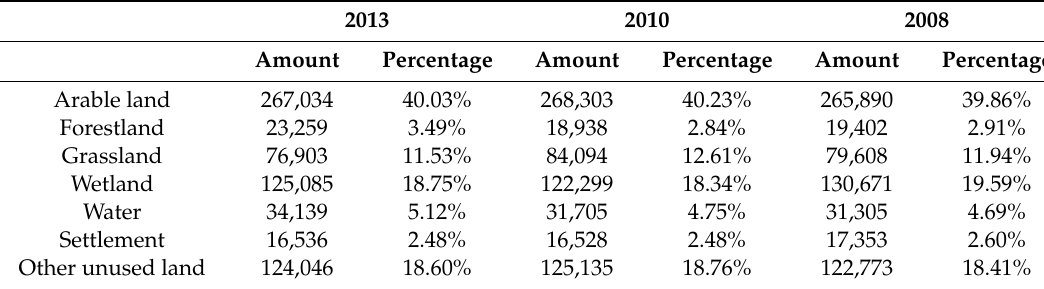
Table 2. Detailed manner of the land use categories in Zhenlai